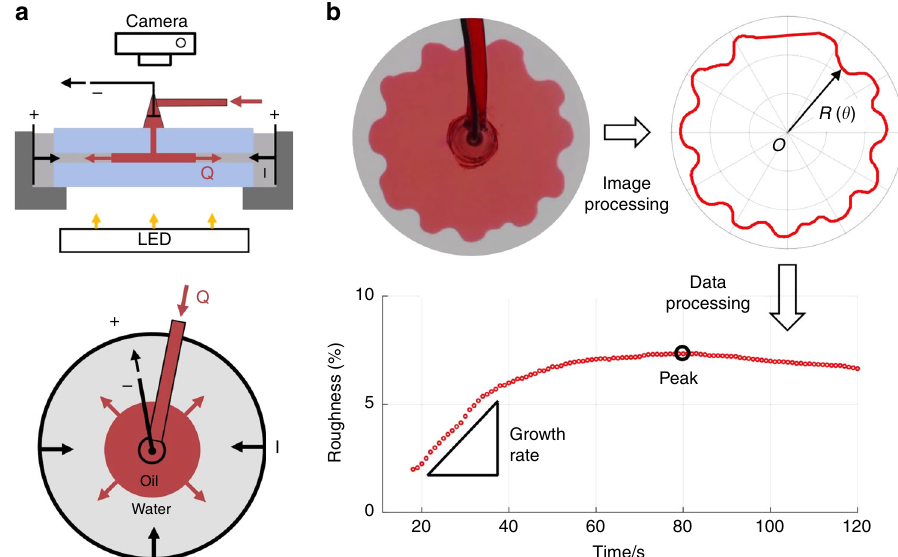
Fig. 2 Experiment apparatus and data processing. a Experiment Apparatus: Top: side view. Bottom: top view. Electric current is applied through two electrodes, one in the center and another encircling the cell. Flow is always injected from center. Positive current is de fi ned to be in the same direction as the fl ow (negative current shown in the schematic). b Image and data processing: the obtained pattern is digitized into a polar plot, and interfacial roughness is calculated for quantifying interface instability